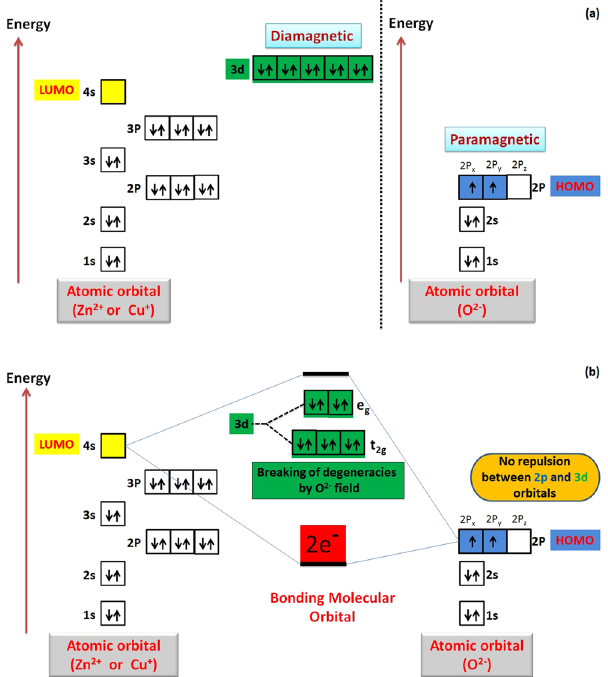
Figure 24. Schematic illustration for splitting of 3d-orbital of cation in the static field of ligand (oxygen anion) and atomic orbitals